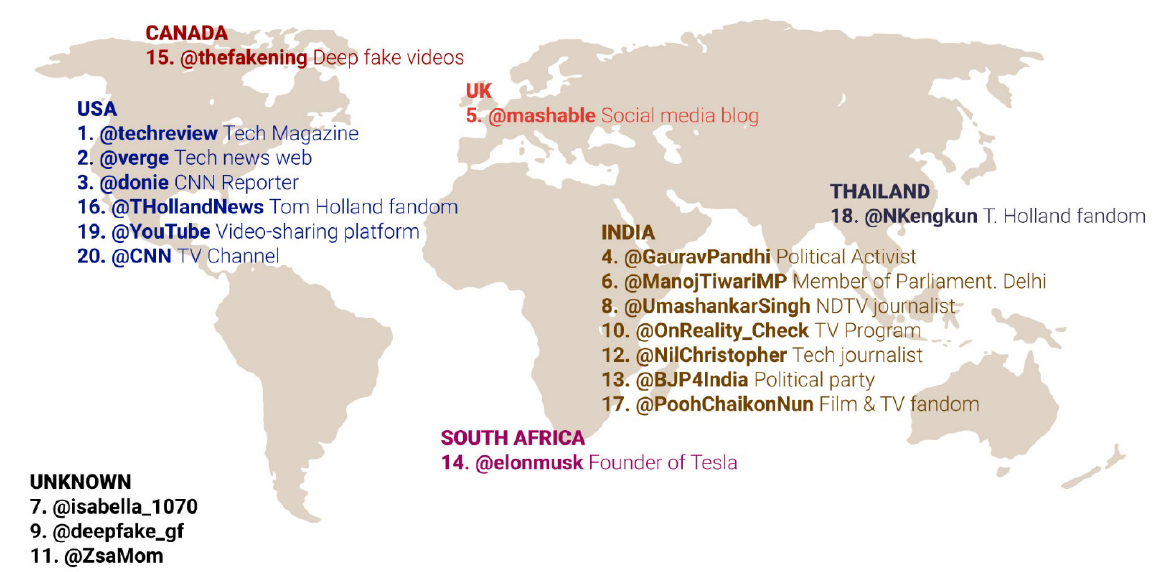
Figure 5. Betweenness degree: Actors who act as bridges in the interactions that shape the